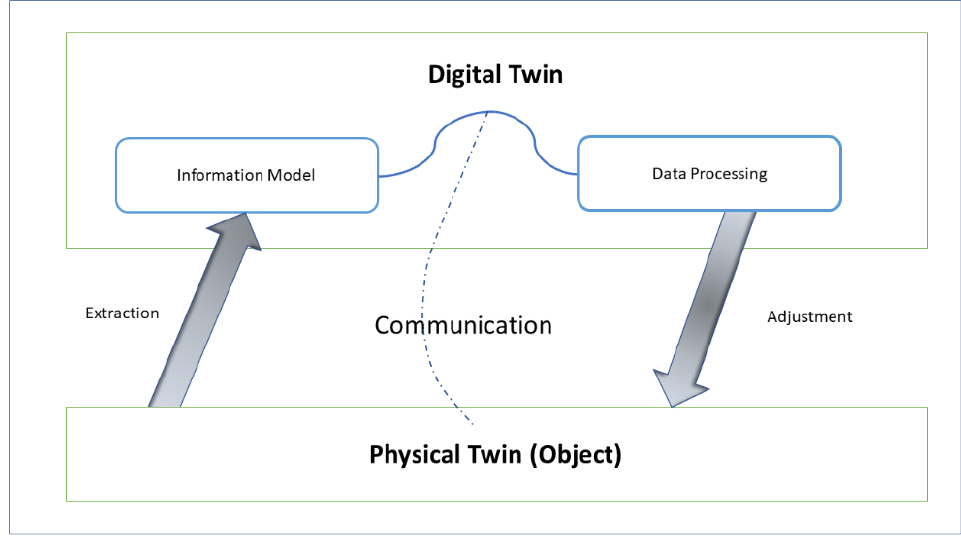
Figure 2. Digital Twinning in line with [5].